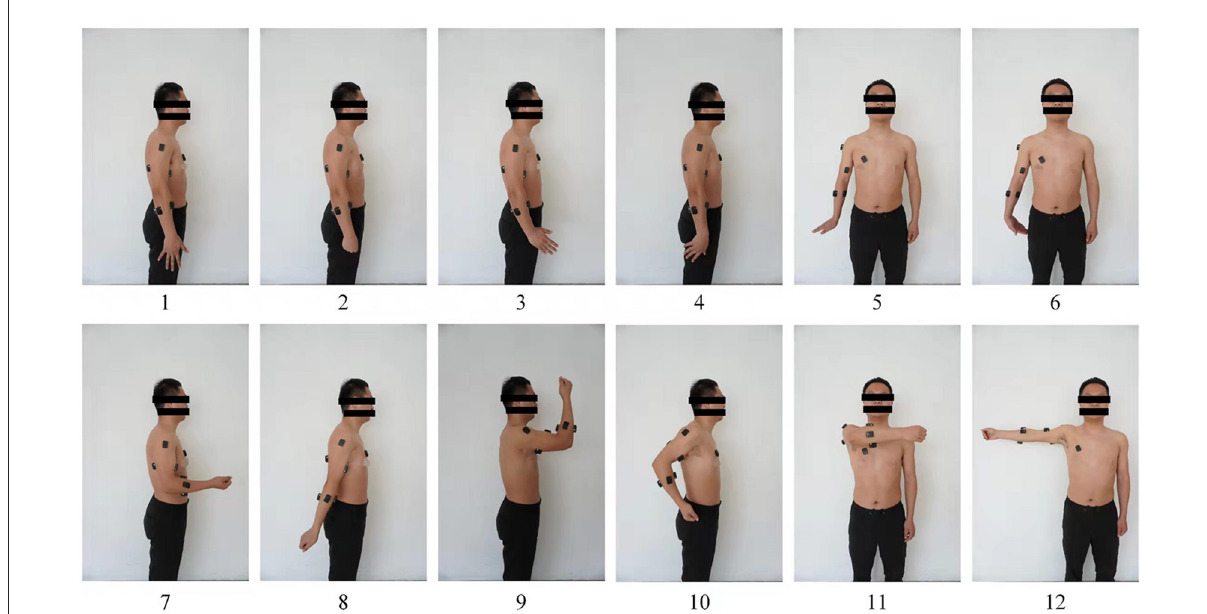
FIGURE4 Upper-limb movements defined in present study: 1—palm extension; 2—fist clenching; 3—wrist abduction; 4—wrist adduction; 5—wrist extension; 6—wrist flexion; 7—elbow flexion; 8—elbow extension; 9—elbow flexion and shoulder flexion; 10—elbow flexion and shoulder extension; 11—shoulder horizontal adduction; 12—shoulder horizontal